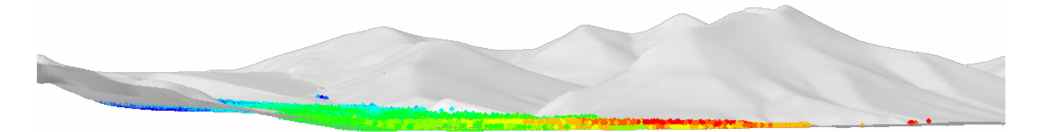
Figure 15. Post-collapse tailing sand accumulation